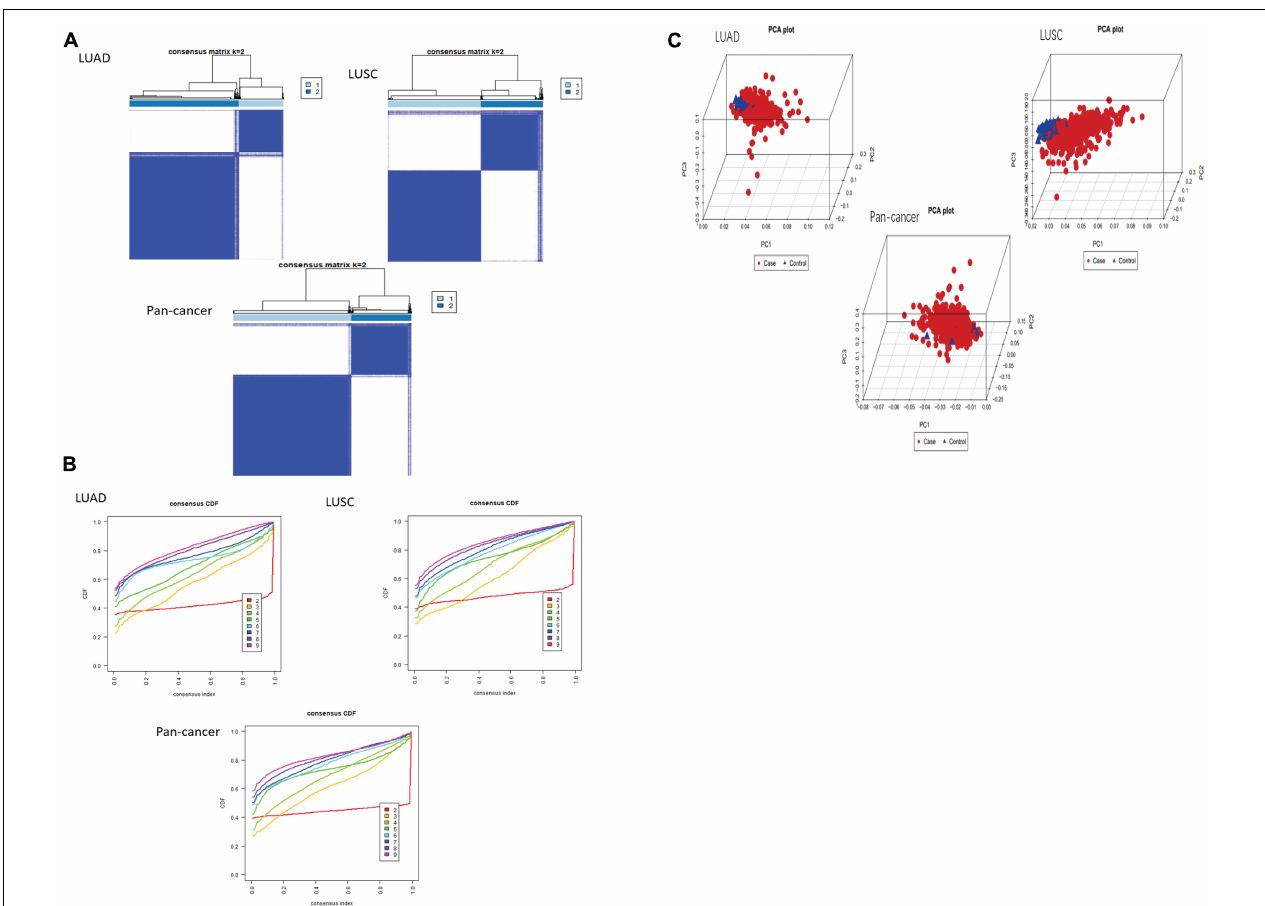
FIGURE 2 | Classification of cluster by m 6 A RNA methylation regulator. (A,B) As K changed from 2 to 9, clustering cumulative distribution function of different lung cancer groups has been shown discriminatively. The consistent clustering matrix is the most suitable when K = 2. (C) PCR analysis results of the principal components are shown in the RNA expression profile among the TCGA database. Red represents lung cancer cases in cluster 1. Blue represents normal lung tissue of cluster 2.